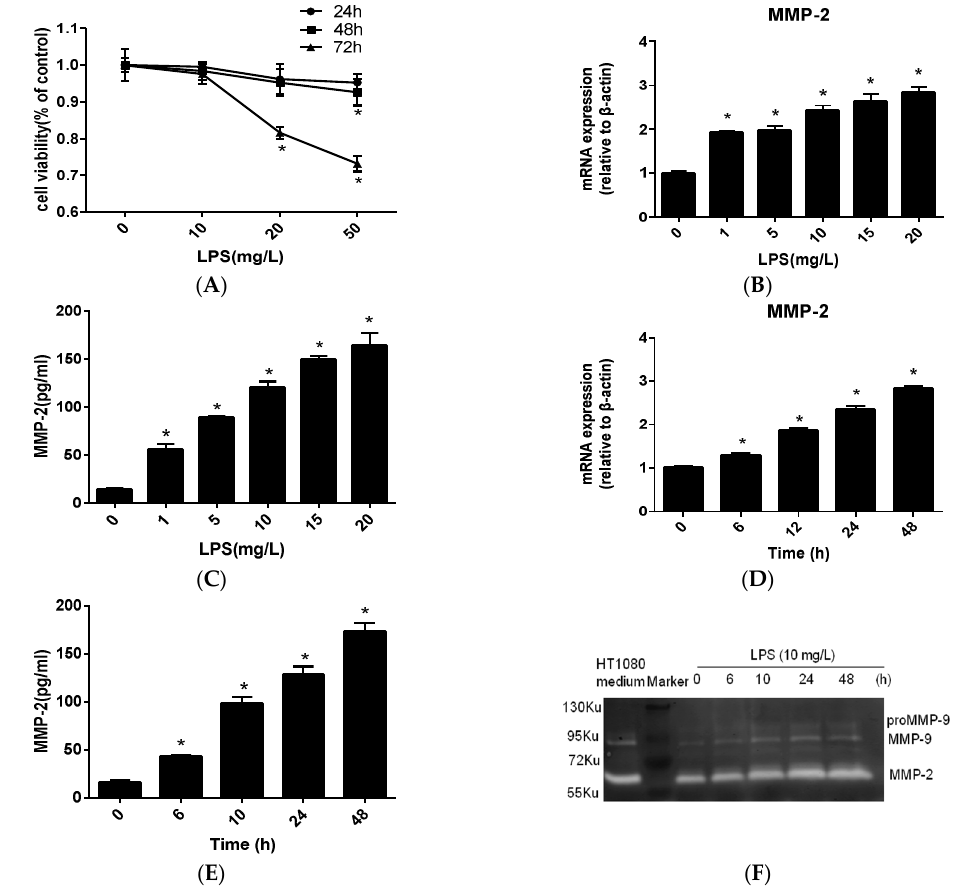
Figure 1. MMP-2 is elevated by P. endodontalis lipopolysaccharide (LPS) treatment in MC3T3-E1 cells. ( A ) MC3T3-E1 cells were treated with P. endodontalis LPS at the indicated concentrations. Cell viability was evaluated by MTT assays after 24 h, 48 h and 72 h of treatment. MC3T3-E1 cells were treated with the indicated concentrations P. endodontalis LPS for 24 h, and MMP-2 expression was determined by real-time PCR ( B ) and ELISA ( C ). MC3T3-E1 cells were exposed to 10 mg L −1 P. endodontalis LPS for the indicated time. MMP-2 expression was determined by real-time PCR ( D ) and ELISA ( E ). ( F ) Gelatinolytic activity produced by MMP-2 was detected by gelatin zymography in MC3T3-E1 cells treated with 10 mg L −1 P. endodontalis LPS for the indicated time. HT1080 medium indicates conditioned medium collected from HT1080 (human fibrosarcoma) cells that was used as a positive control. U is the atomic mass unit. 1 Ku is approximately equal to 1 KDa. * p < 0.05, as compared to the control group.